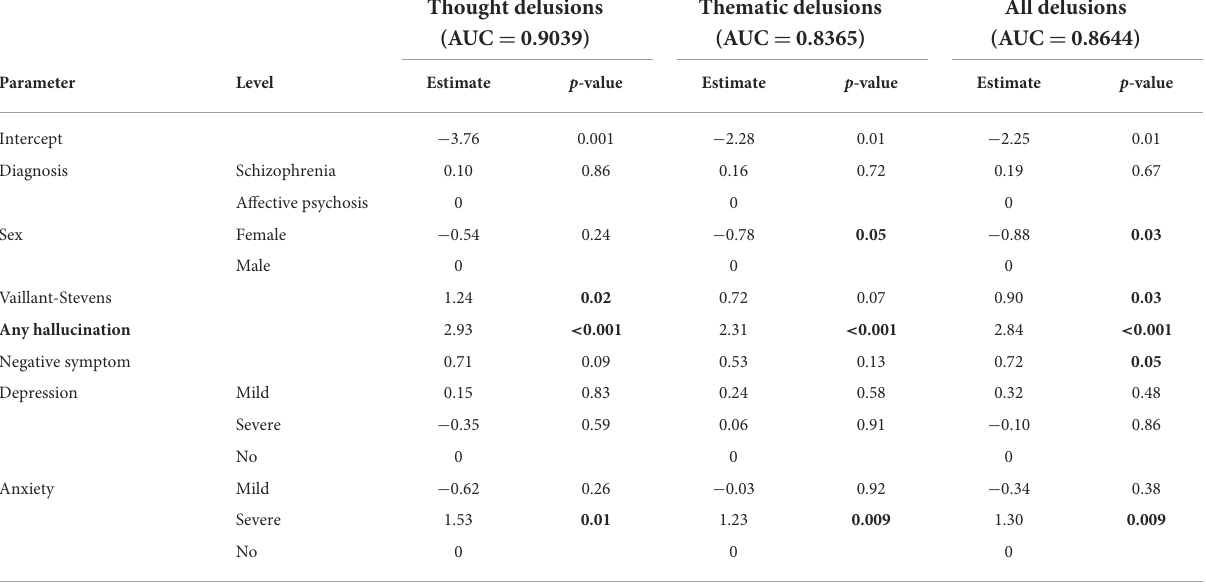
TABLE 2 Fitted logistic GEE models for Thought, Thematic, and All